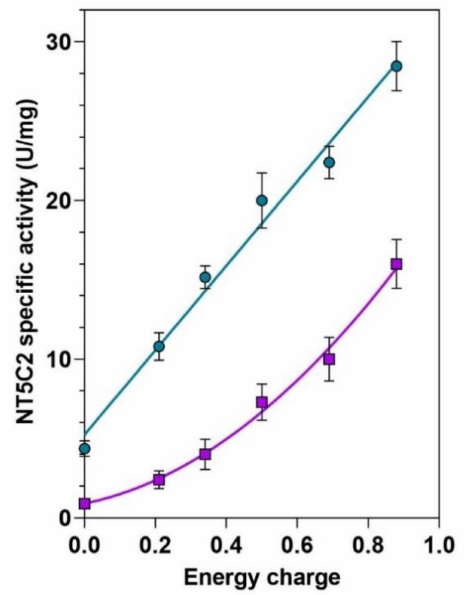
Figure 1. NT5C2 activity is dependent on the adenylate energy charge. The phosphotransferase activity of wild-type (WT) recombinant NT5C2 was evaluated in vitro at different energy charge values obtained with various concentrations of ATP, ADP and AMP, both in the absence ( the presence ( (cid:3) ) of 5-mM Pi. Results are the mean + SD of three independent